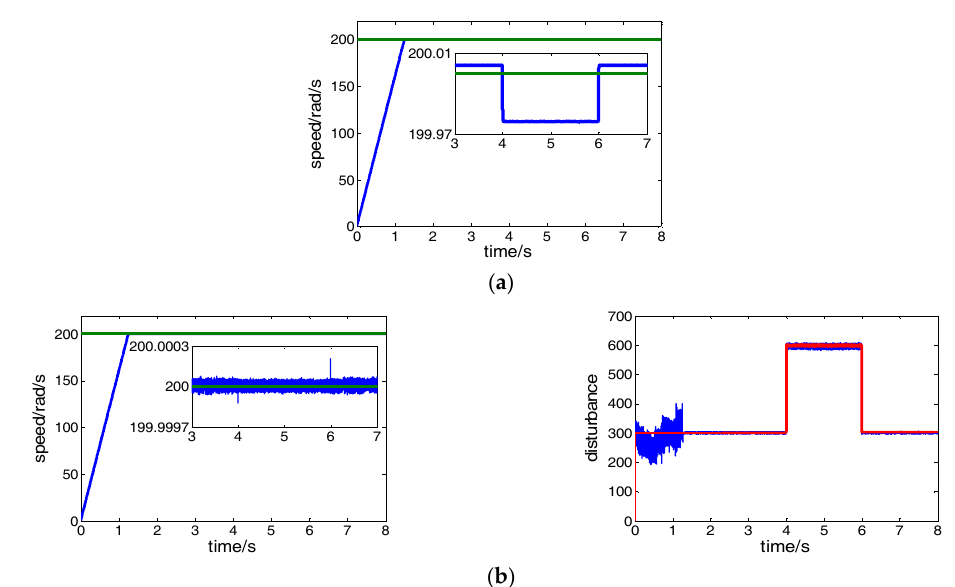
Figure 8. Simulation comparisons of the two controllers against step change of the flux linkage: ( a ) Conventional PI and ( b ) proposed CRFTPC.